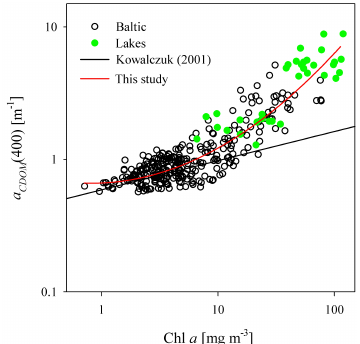
Figure 3. Dependence between coefficients of light absorption by CDOM a CDOM (400) and chlorophyll a concentration. The black line shows the approximation obtained by Kowalczuk (2001) and the red line shows the second-degree polynomial approximation on the log–log